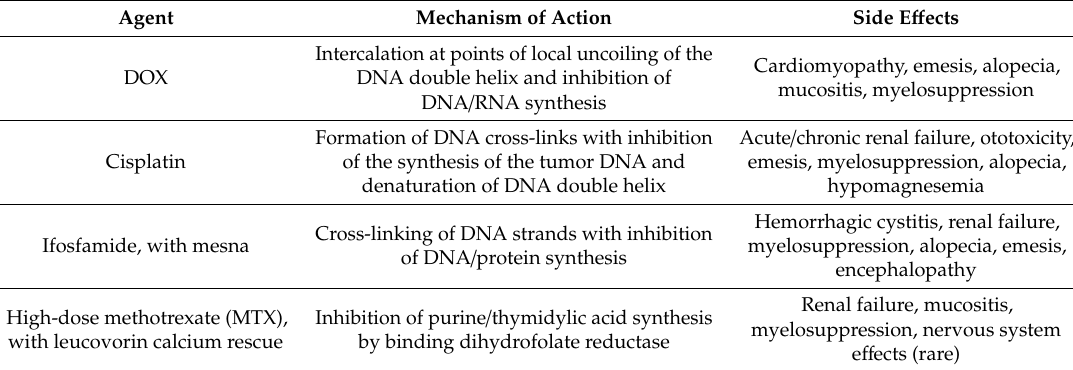
Table 4. Chemotherapeutic agent used in the treatment of OS [25].